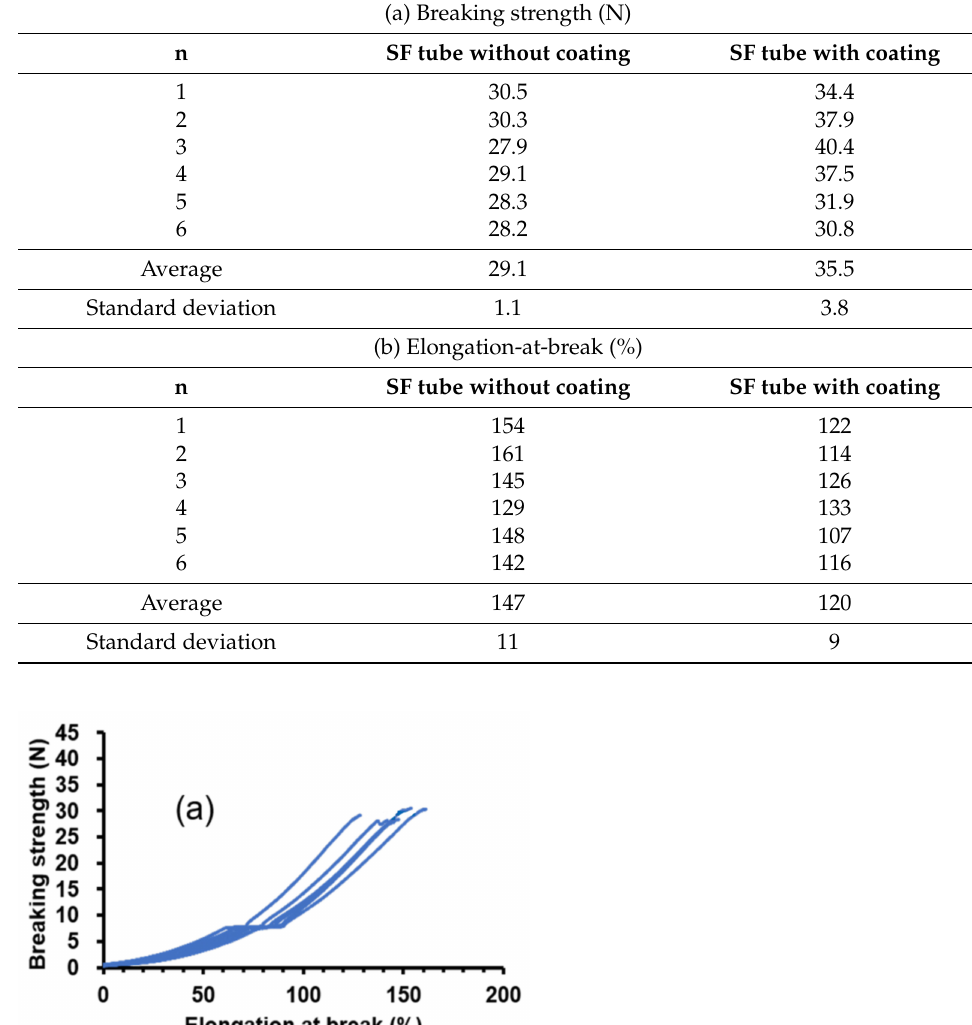
Table 3. The breaking strength (N) and elongation-at break (%) calculated from the stress-strain curves (Figure 8) of hydrated 3.5mm diameter SF knitted tubes without and with PU-SF composite sponge coating.